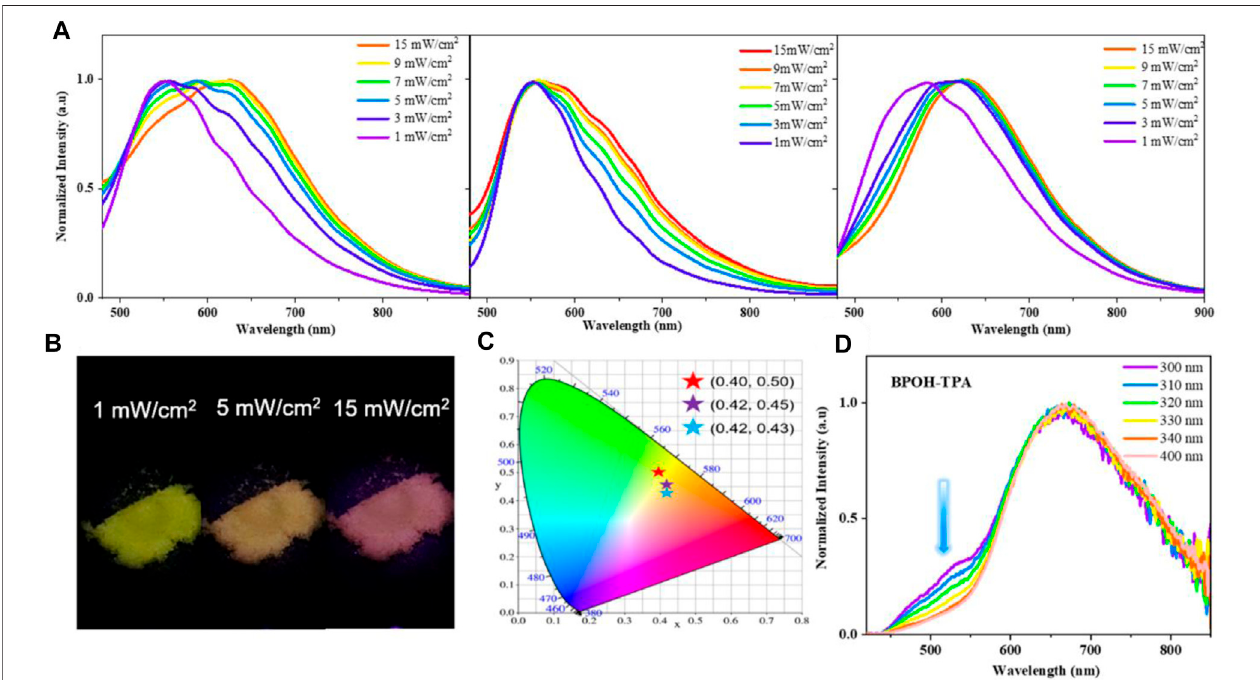
FIGURE 3 | (A) Dependence of the emission spectra of BPOH-TPA, BPOH- PhCz, and BPOH-SF upon different power densities (1 – 15 mW/cm 2 ), λ ex (cid:2) 365 nm. (B) The photographs of BPOH-TPA powder taken under the excitation power of 1, 5, and 15 mW/cm 2 , with the (C) CIE 1931 chromaticity coordinates of (0.40, 0.50), (0.42, 0.45), and (0.42, 0.43), respectively. (D) Emission spectra of BPOH-TPA upon different excitation wavelengths (300 − 400